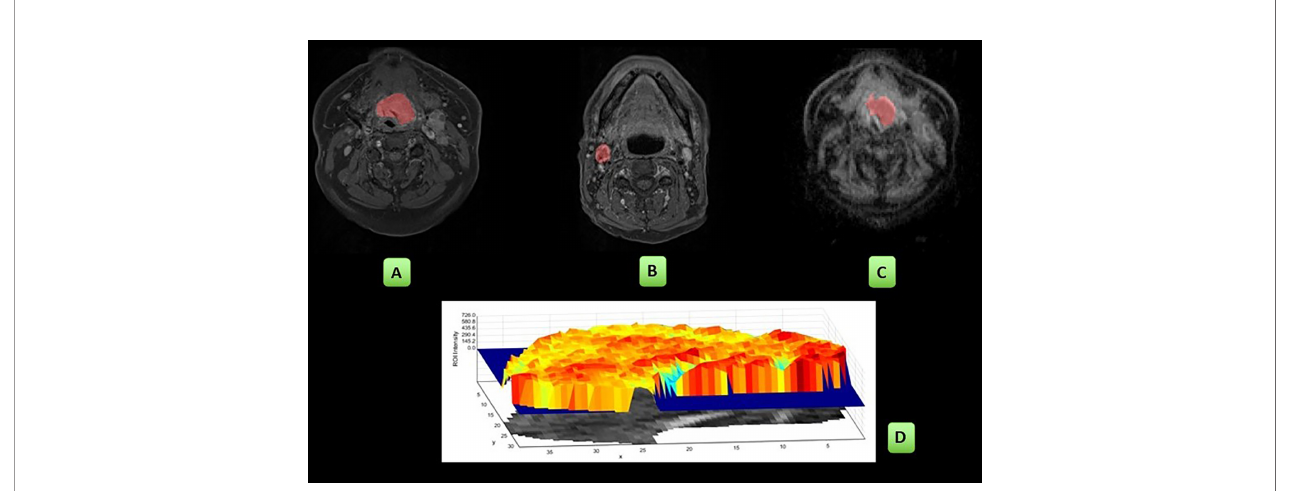
FIGURE 1 | Work fl ow of the study: ROIs were placed on the post gad T1w sequences: primary tumour (A) , single largest pathological lymph node (B) and on the ADC map: primary tumour (C) . The radiomics fi rst- and second-order parameters were derived and are pictorially depicted here by a sample of the shaded surface intensity histogram (D) . These analyses were then repeated at the 6- and 12-week MRI